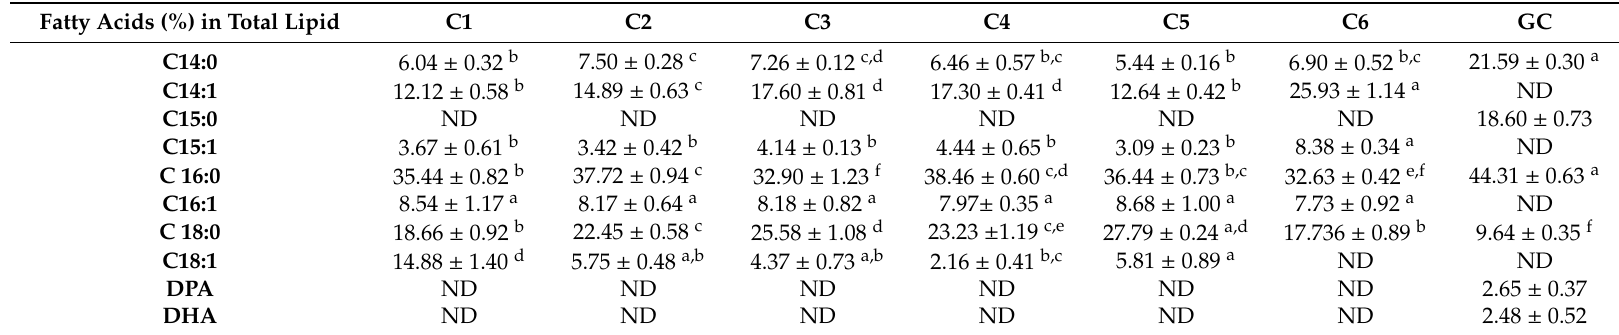
Table 1. Fatty acid composition (wt% of total fatty acids) of Aurantiochytrium sp. T66 cultivated on 2 g / L of various VFAs (C1:0, formic acid; C2:0, acetic acid; C3:0, propionic acid; C4:0, butyric acid; C5:0, valeric acid and C6:0, caproic acid). Glucose (GC) was used as control. Fatty Acids (%) in Total Lipid